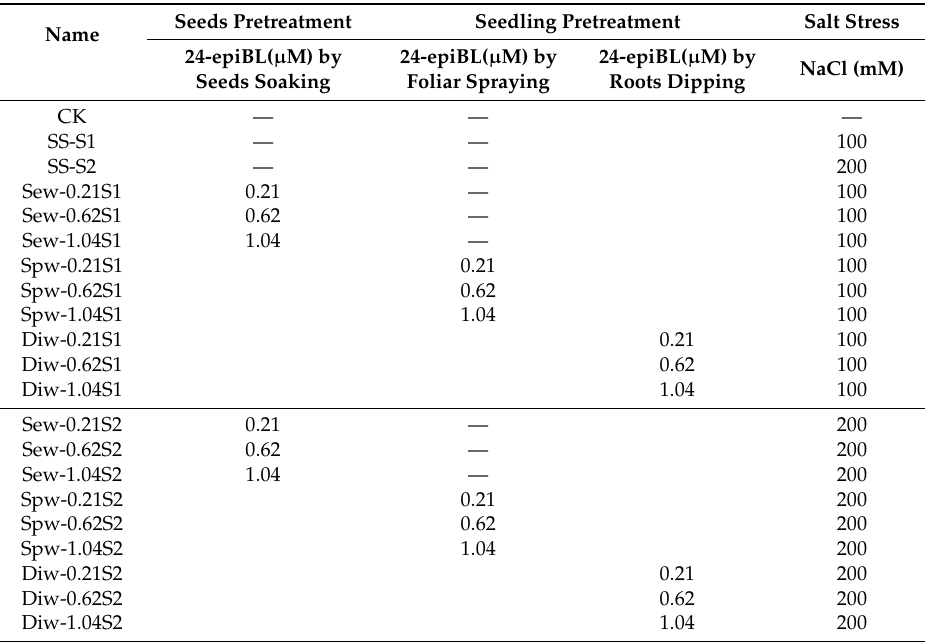
Table 1. The different treatments’